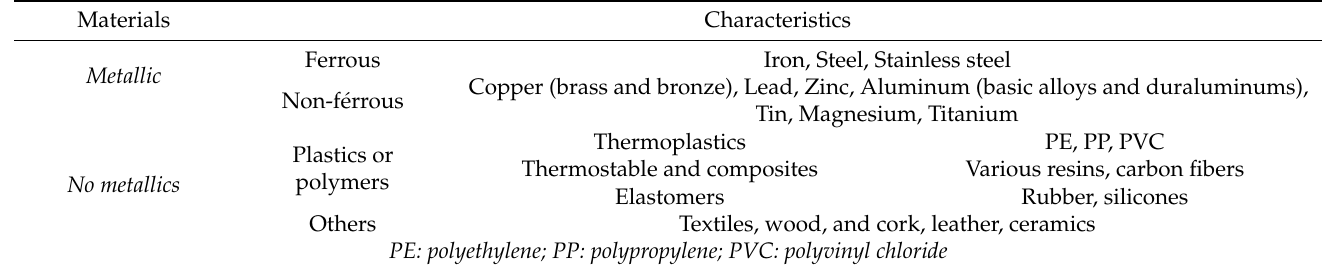
Table 2. Orthopedic